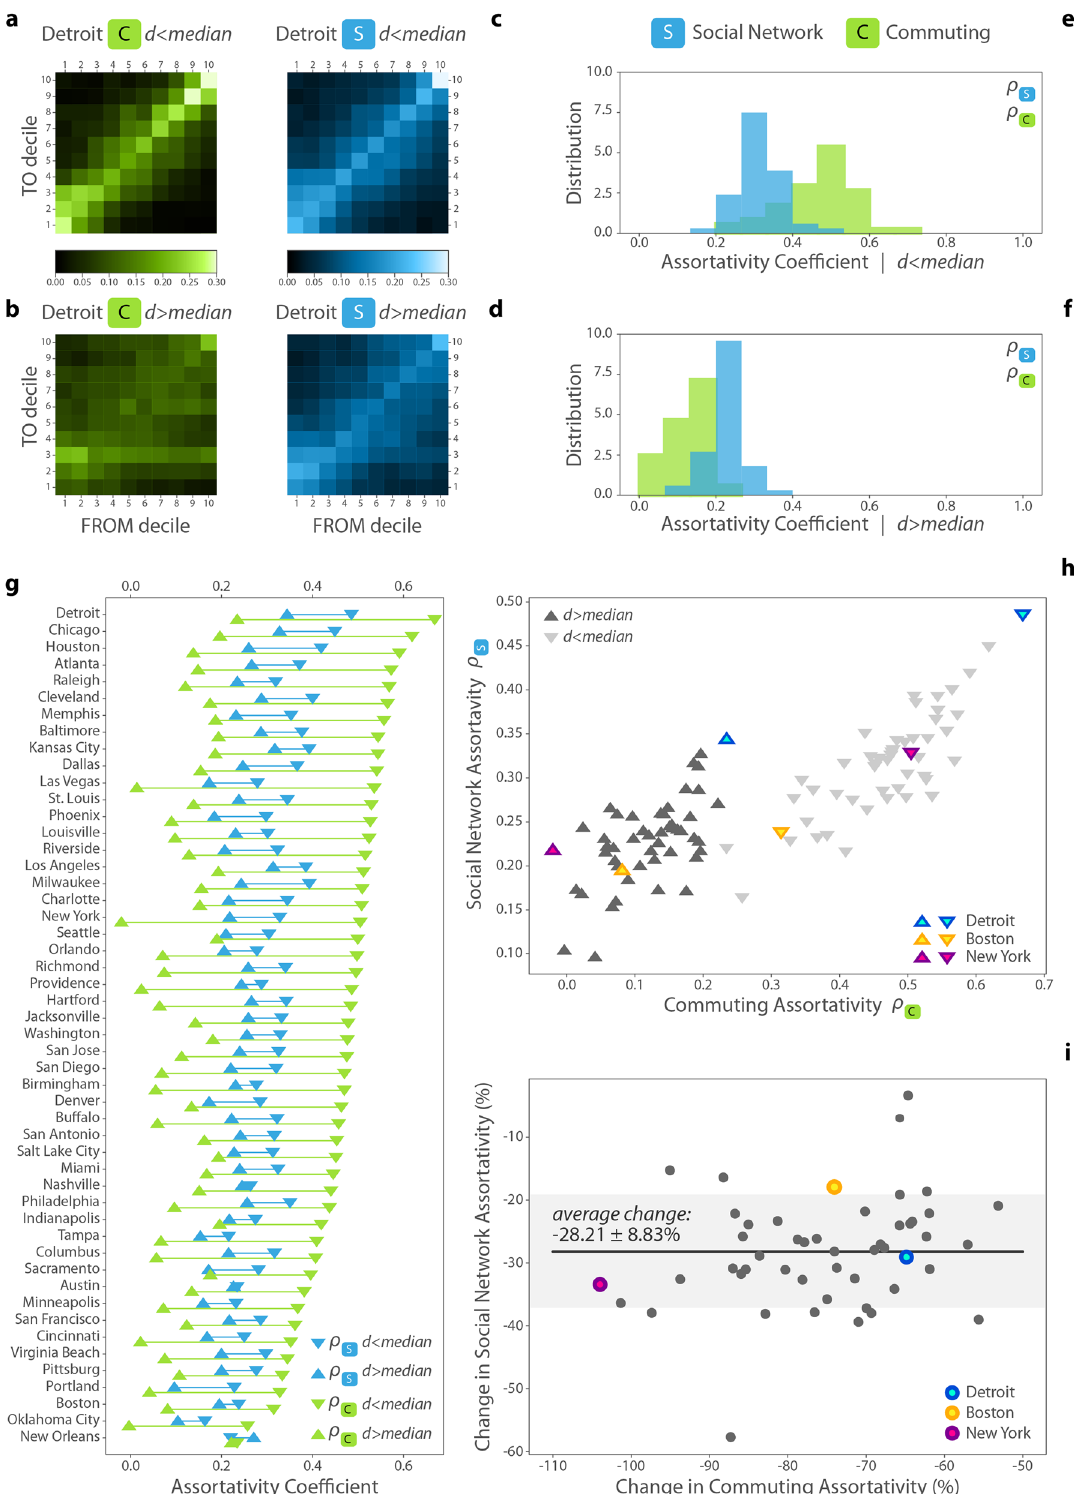
Figure 4. Panels ( a – d ) show the C and S assortativity matrices for the below ( d < median ) and above median ( d > median ) commuting users in a selected metropolitan area, Detroit. ( e , f ) The corresponding distributions of ρ C (green) and ρ S (blue) for all 50 metropolitan areas for users with d > median and d < median . ( g ) Pairwise values of ρ C and ρ S for users with d > median and d < median by metropolitan areas. Metropolitan areas are sorted in decreasing order by ρ C for easier representation. ( h ) Social network assortativity versus commuting assortativity for below and above median commuters with selected cities from Fig. 3 labeled. ( i ) Decrease in the commuting assortativity and the social network assortativity measured in percentage. Black horizontal line corresponds to the average change in social network assortativity. Grey shaded area marks the standard